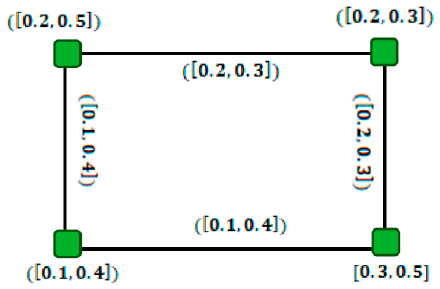
Figure 11. Complement of Figure 10 based on Definition 9.